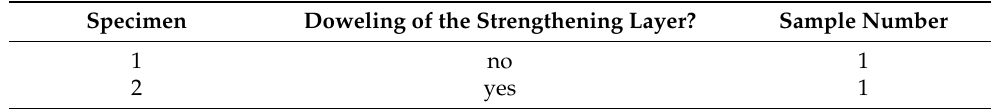
Table 5. Overview of the tested